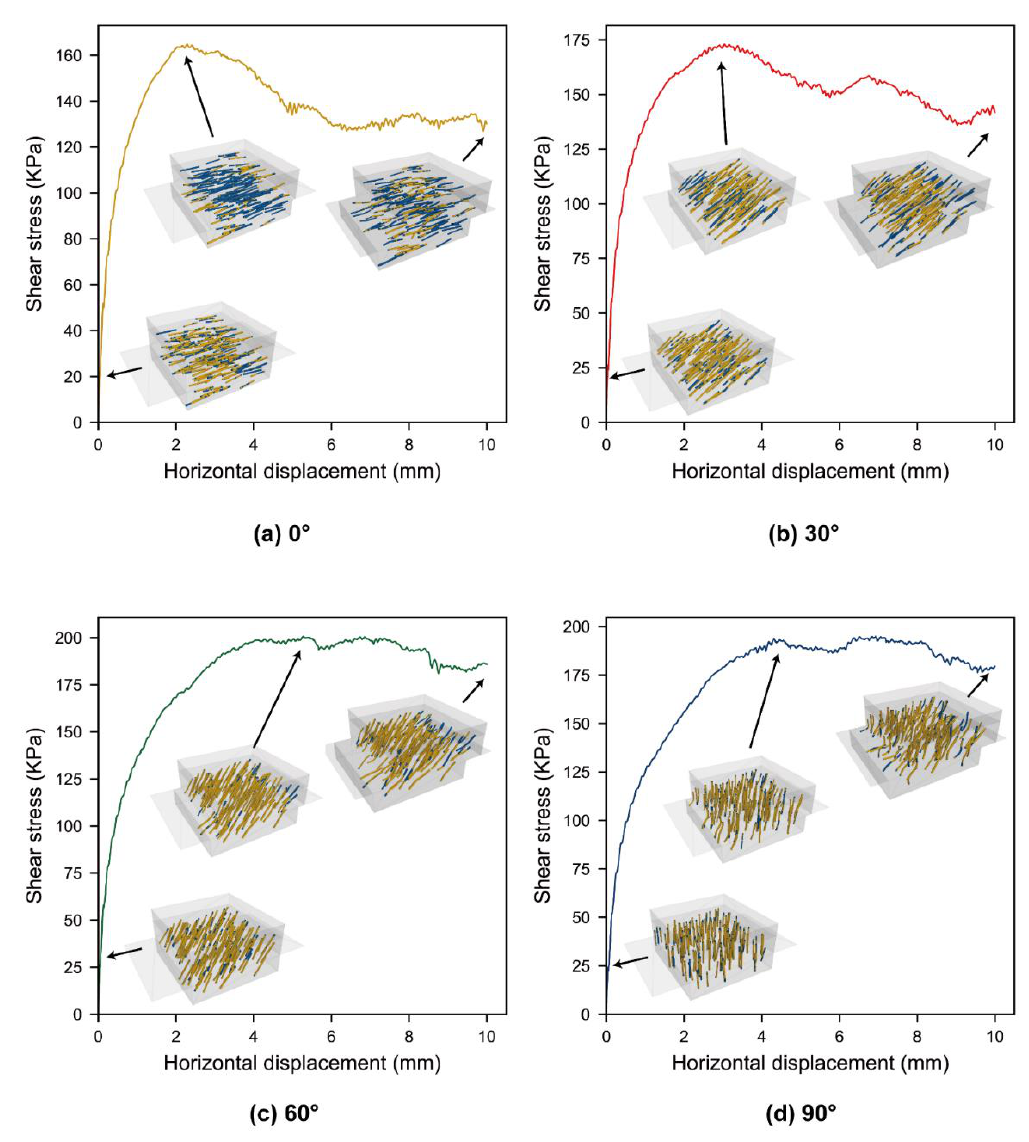
Figure 15. Spatial distributions of force in fibers (blue: compression; yellow: tension).